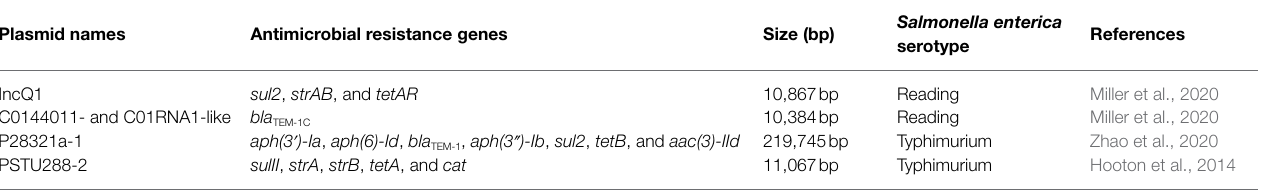
TABLE 3 | Examples of mobilizable IncQ plasmids identified in Salmonella enterica